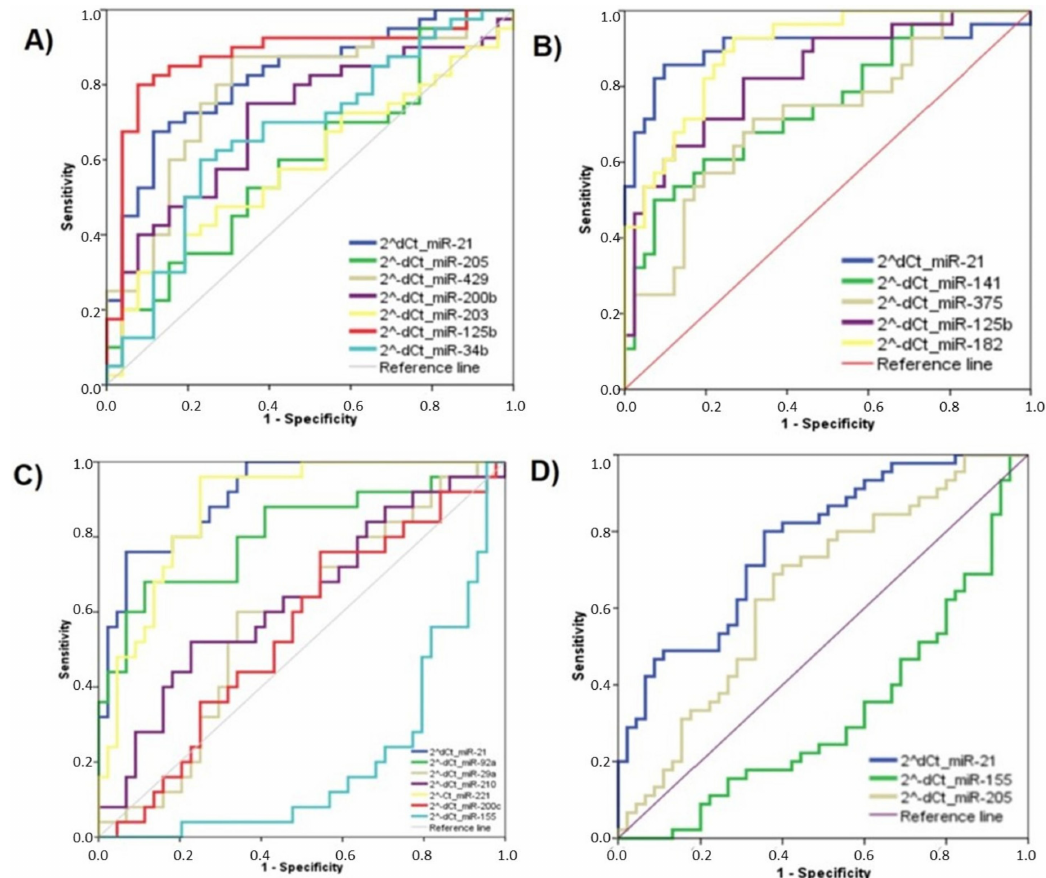
Figure 4. ROC curves of the selected circulating miRNAs selected for each tumor type: ( A ) LC for miR-21, miR-205, miR-429, miR-200b, miR-203, miR-125b, and miR-34b; ( B ) PCa for miR-21, miR-141, miR-375, miR-125b, and miR-182; ( C ) CRC, for miR-21, miR-92a, miR-29a, miR-210, miR-221, miR-200c and miR-155; and ( D ) BC, for miR-21, miR-155, and